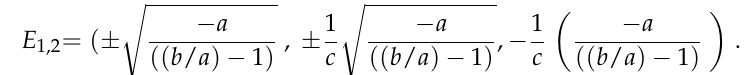
Figure 1. Phase portraits of the hidden chaotic attractors obtained from the system (5): ( a ) x-y pro- jection; ( b ) x-z projection; ( c ) y-z projection; ( d ) x-y-z 3D arrangement.